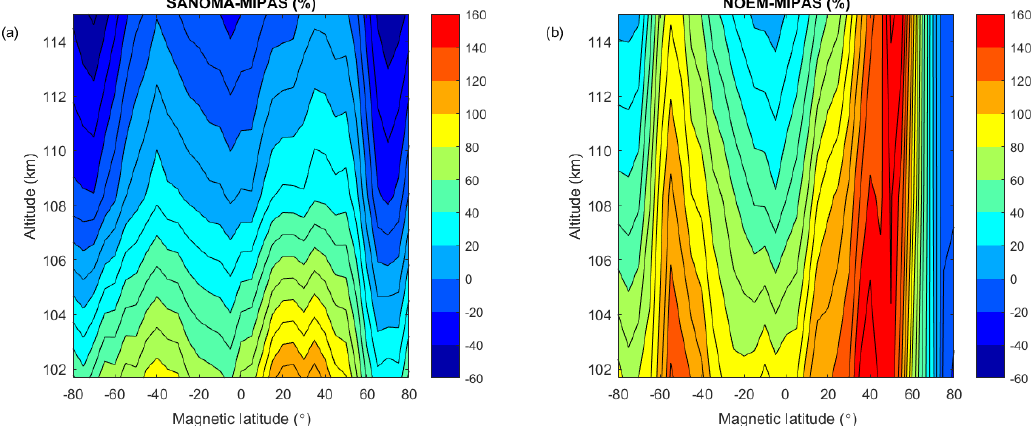
Figure 23. (a) Median difference between SANOMA and MIPAS as a percentage of mean MIPAS NO number density. (b) Median difference between NOEM and MIPAS as a percentage of mean MIPAS NO number density.